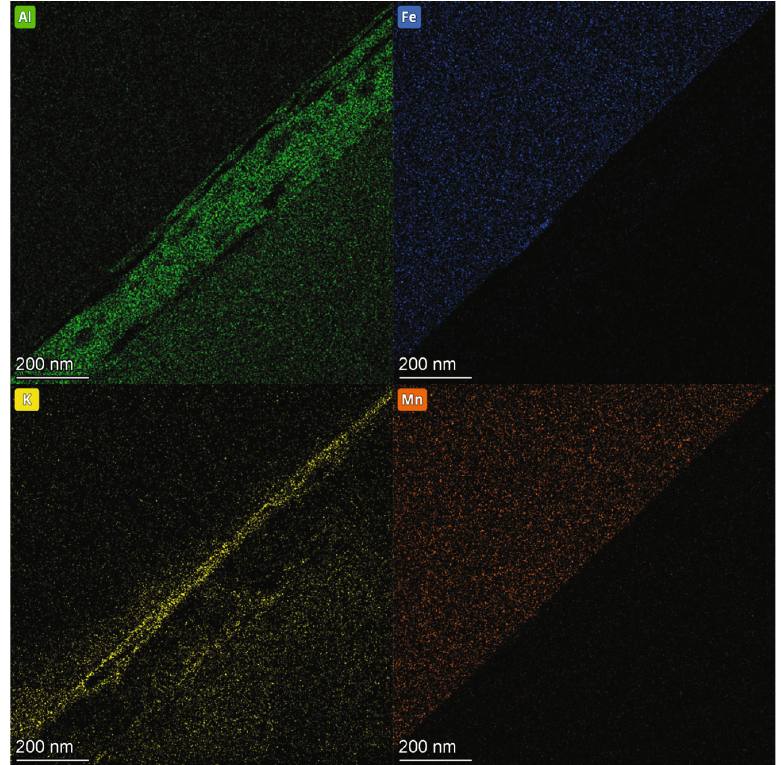
Figure 7: Al, Fe, K, and Mn maps of a FIB-cut of the columbite-tantalite mineral. The location of this FIB-cut is the same as in Figure